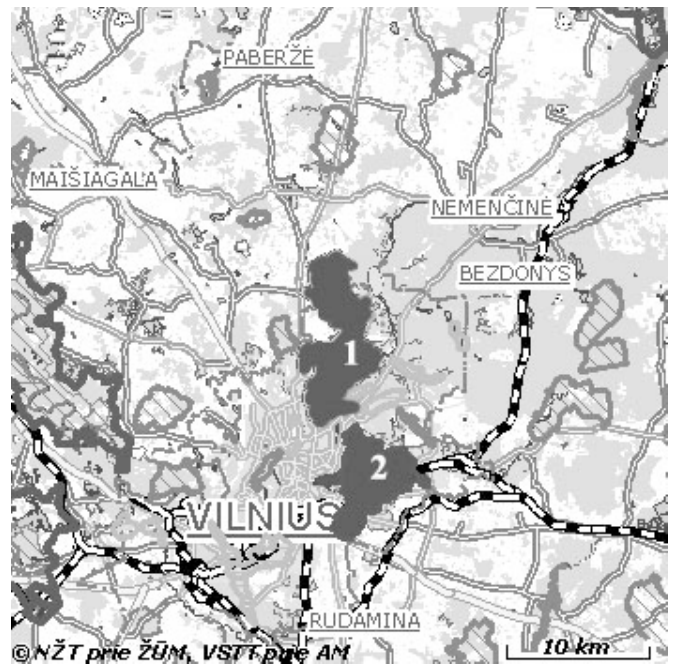
Fig. 1. Location of Verkiai (1) and Pavilniai (2) regional Parks (map from state cadastre of protected areas: http://stk.vstt.lt,